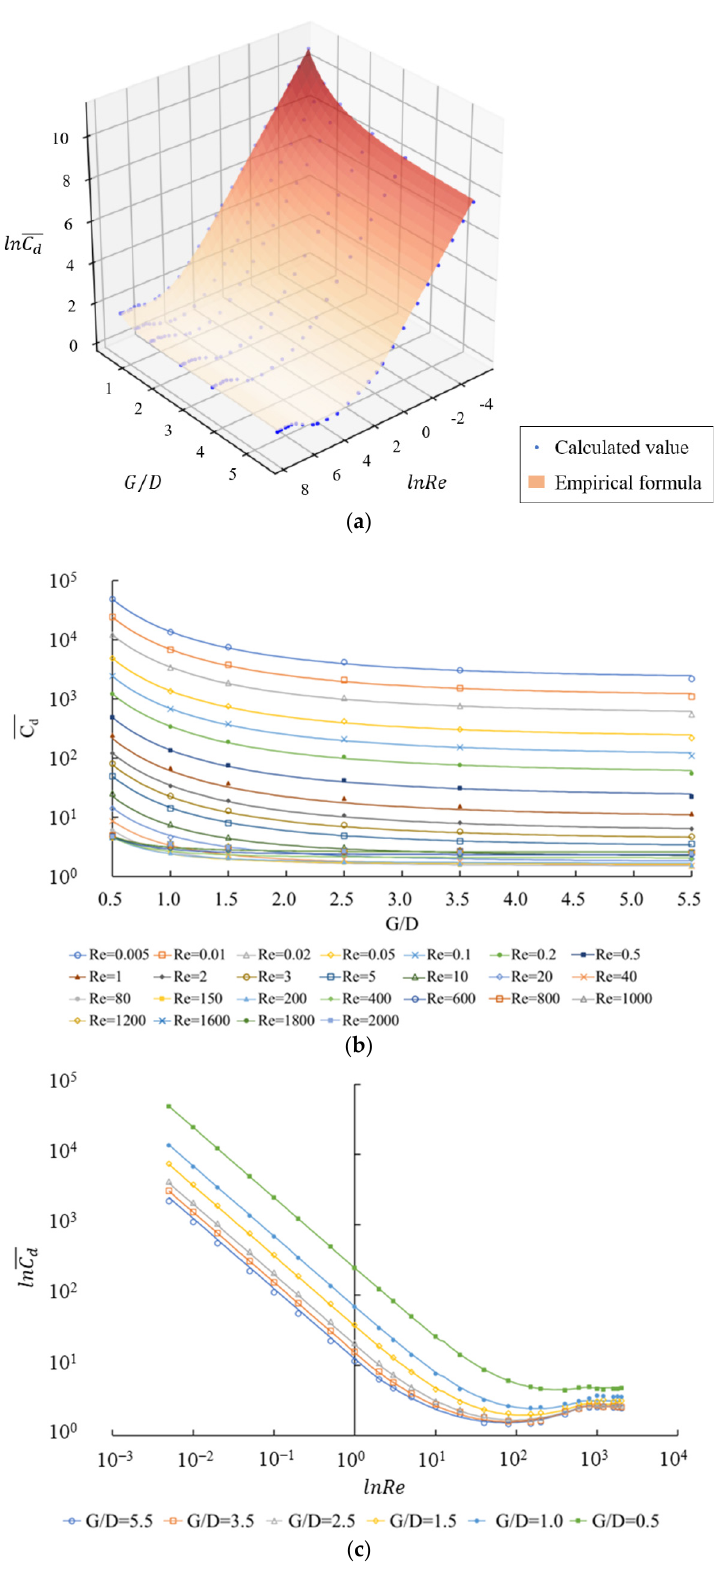
Figure 10. Relationship of C d nd G / D , R e . ( a ) lnC d versus lnRe and G / D ; ( b ) C d versus G / D ; and ( c ) lnC d versus lnRe